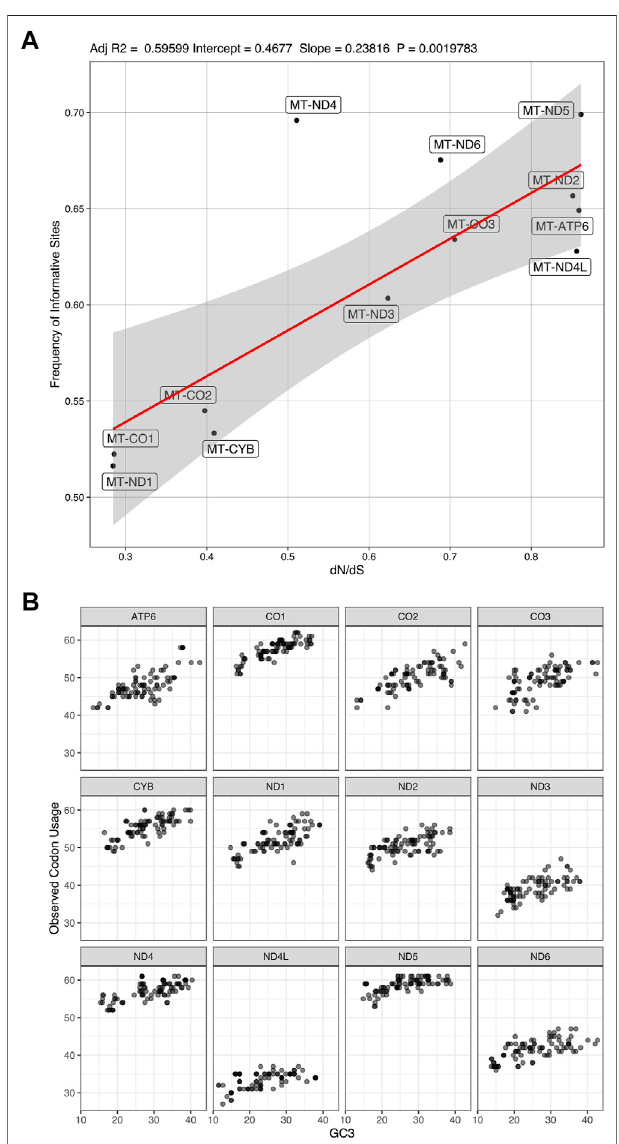
FIGURE 7 | Frequency of informative sites and codon usage. (A) . correlation between the frequency of dN/dS mutations and number of informative sites (Adjusted R2 (cid:1) 0.59599; Intercept (cid:1) 0.4677; Slope (cid:1) 0.23816; p -value (cid:1) 0.0019783). (B) . codon usage variation among the mitochondrion coding genes in relation to content in the third codon